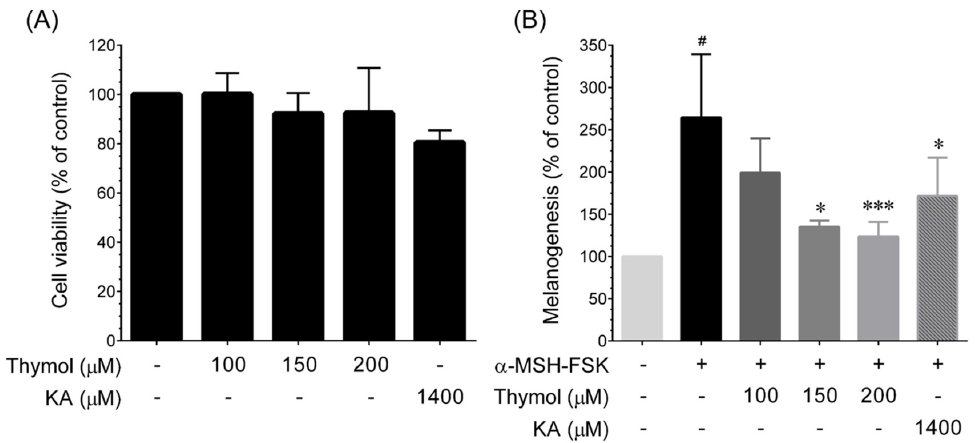
Figure 6. Effect of thymol on melanin inhibition. ( A ) Cells were incubated with increasing doses of thymol (100, 150, and 200 µM) or KA (1400 µM) for 72 h. Cell viability was determined by MTT colorimetric assay. Data represent the mean ± SD of three independent experiments. ( B ) Cells were treated with increasing concentrations of thymol or KA and stimulated with α -MSH-FSK for 72 h. The cellular melanin content was determined by colorimetric assay. Data represent the mean ± SD of three independent experiments. Statistical significance was set as # p < 0.01 compared with control vs. α -MSH-FSK and * p < 0.05, and *** p < 0.001 compared with sample treatment groups vs. α -MSH-FSK treatment group.